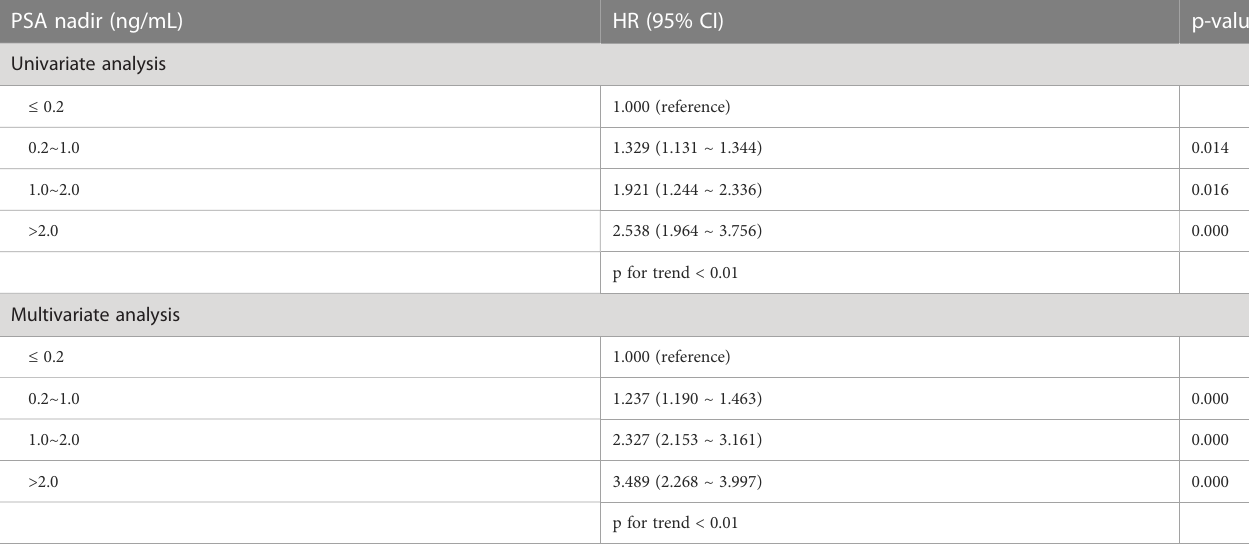
TABLE 3 Cox regression analysis of the relationship between PSA nadir and